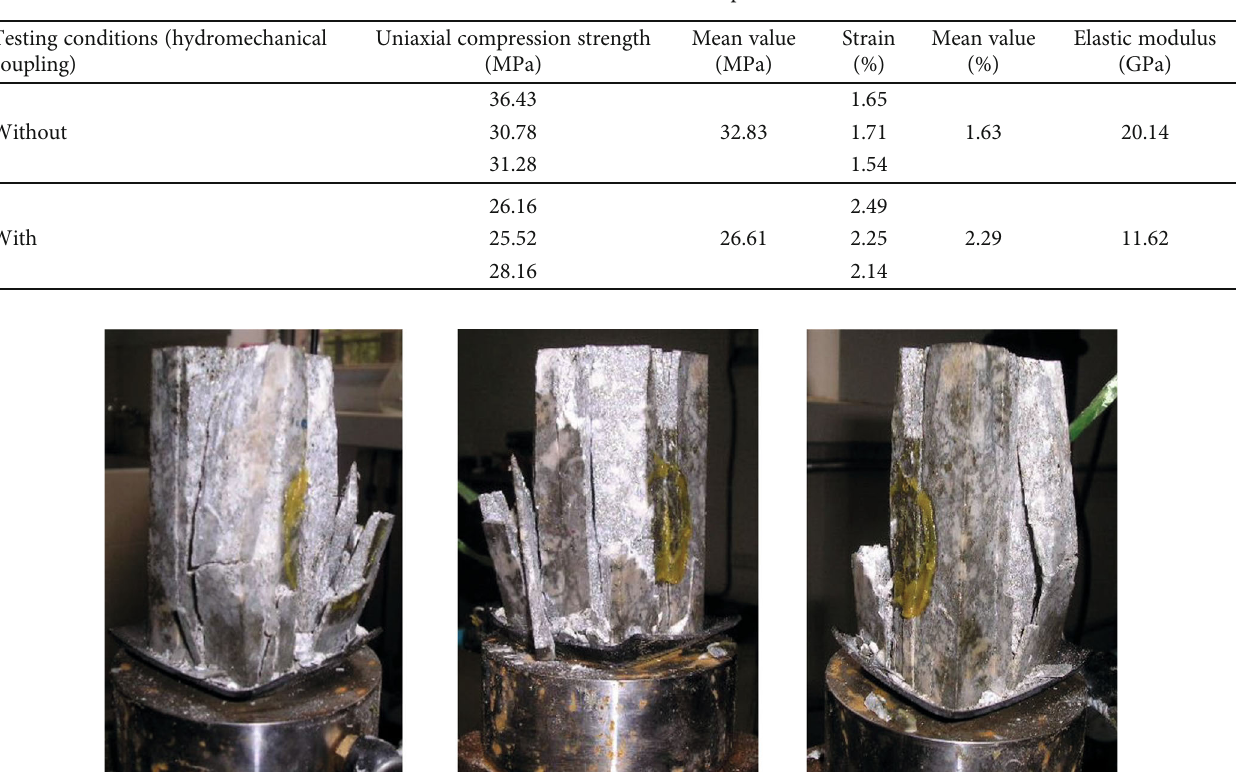
Figure 4: The stress-strain curve of the specimens with the seepage. Table 1: The variation of mechanical parameters.